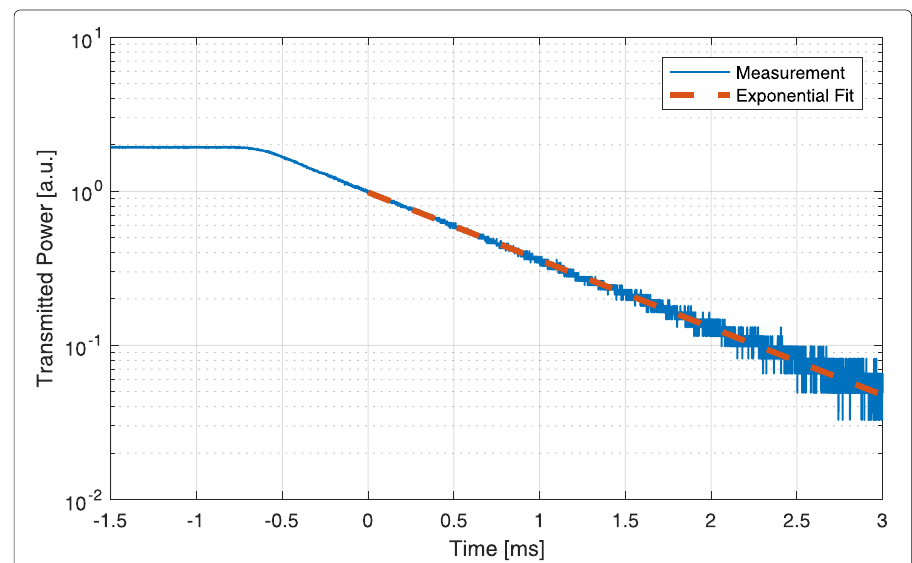
Fig. 2 Storage time measurement. The cavity storage time is a measurement of the exponential decay of the transmitted power when the laser shutter is